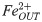
DMT1 swinging-mechanism model.DMT1 in the apical membrane unbound to iron and oriented to the intracellular side (P4) can be endocyted into iron containing vesicles (P5), where it can change to a state (P6) capable of iron release. (orange circle): apical iron concentration (FeOUT2+); (brown circle): iron concentration in the intracellular-basolateral space (FeIN2+). Extracellular iron FeIN2+ is considered to be a regulatory factor in endocytosis, represented as dashed modulator arrow (-- •). The autocatalytic reactions of states P4, P5 and P6 is represented by a dashed circular modulator arrow.